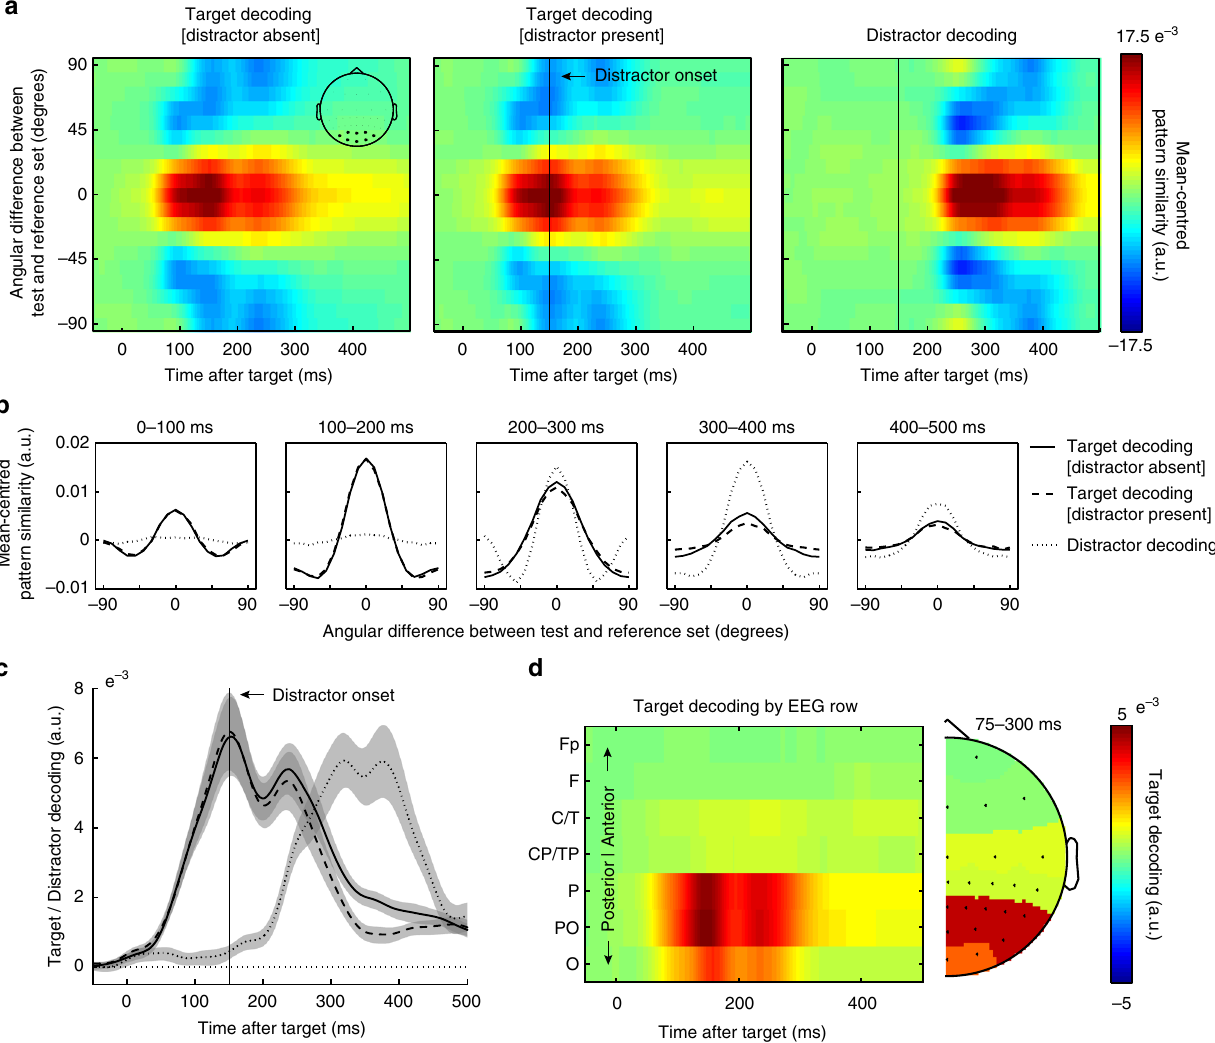
Fig. 2 Time-resolved EEG orienting decoding of targets and distractors. a Time-resolved orientation tuning pro fi les. Data represent the mean-centred pattern similarity (quanti fi ed using the Mahalanobis distance) between the test trials and the reference trials, as a function of the angular difference between test and reference trials ( y axis). The inset in the leftmost panel highlights the eight electrodes that were used for the orientation decoding analysis. b Average tuning pro fi les for the data in panel a , in fi ve successive time windows. c Time courses of the corresponding summary decoding statistic (Methods for details). d Time-resolved decoding (summary statistic) as a function the EEG electrode row used for decoding. Topography plot to the right shows the same data in a more conventional manner whereby the value in each electrode indicates how well the row to which that electrode belongs is able to decode target orientation. Error bars represent ± 1 s.e.m calculated across participants ( n = Per time point, we calculated the multivariate Mahalanobis between test and reference trials, we were able to reconstruct distance (using electrodes as dimensions) between the left-out orientation tuning pro fi les (as in ref. 22 ). We mean-centred trial (the test trial) and all other trials (the reference or training (across all angular differences) the obtained distances and trials) — in which the target or distractor orientation was at a inversed the data such that lower distances (re fl ecting higher particular angular difference from the test trial. By evaluating this pattern similarity) are plotted as positive values (as in ref. 22 ). multivariate distance metric for a range of angular differences